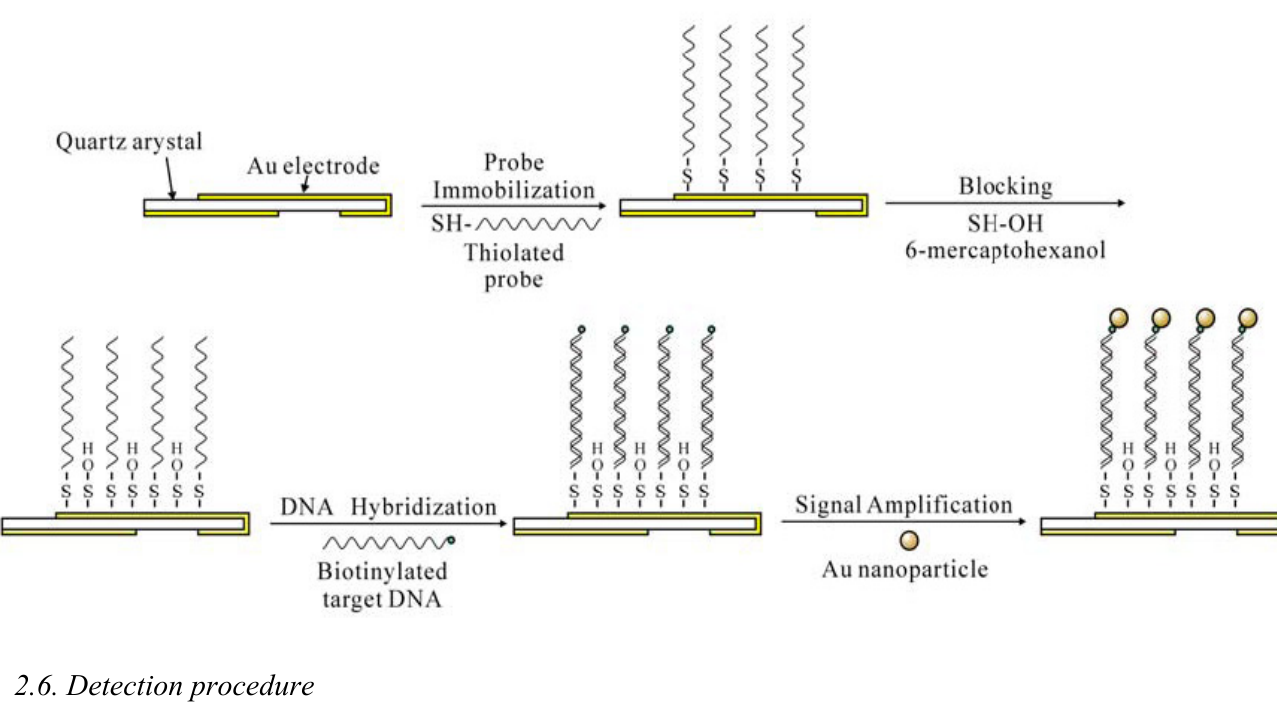
Figure 2. The assembly procedure of the QCM nucleic acid